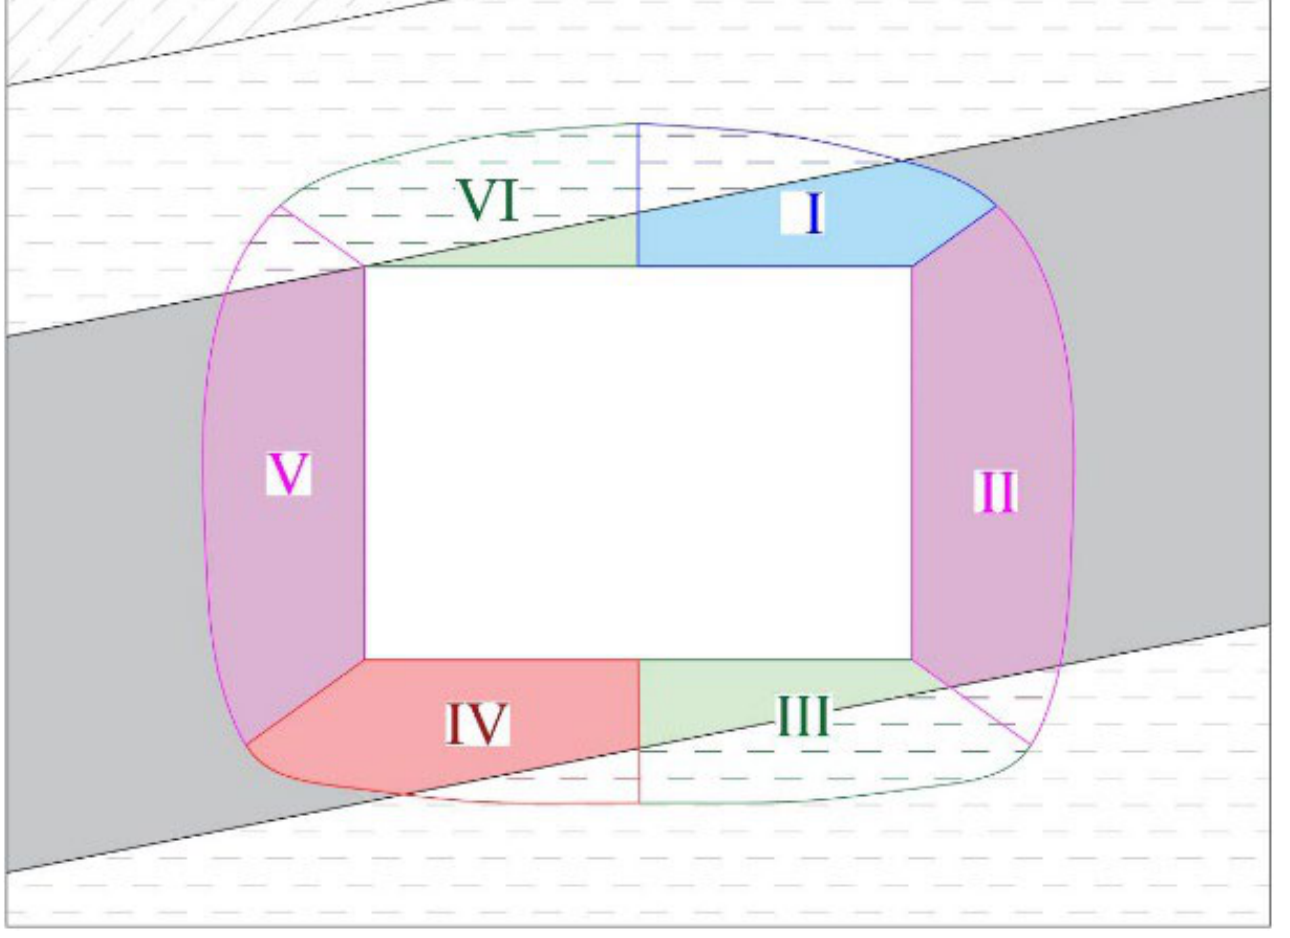
Figure 14. Division of the surrounding-rock areas of the roadway in inclined rock strata.